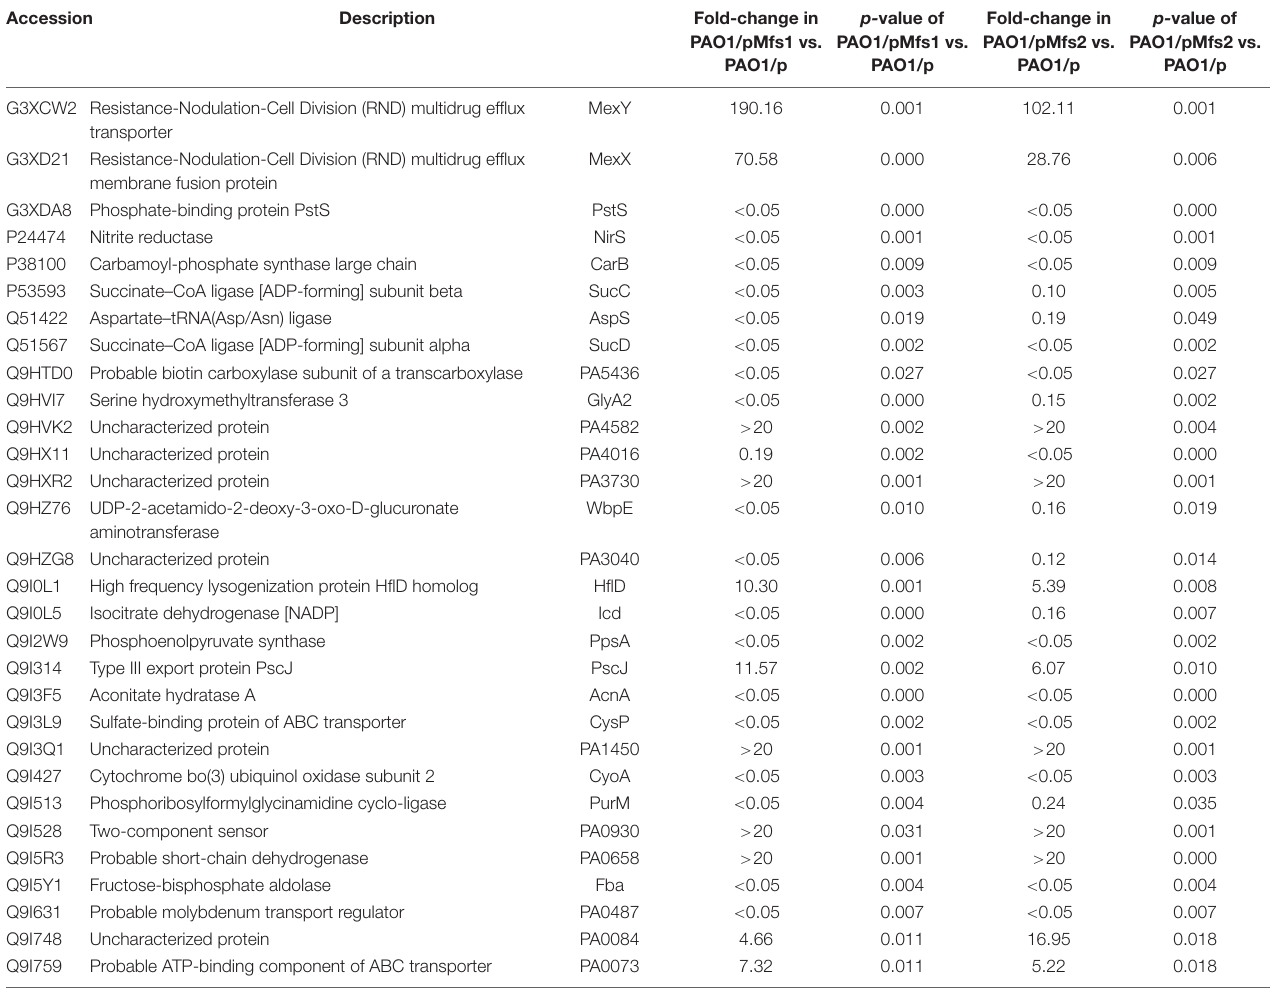
TABLE 2 | List of significant protein abundance changes observed in PAO1 / pMfs1 and PAO1 / pMfs2 relative to PAO1 / p. Accession Description Fold-change in